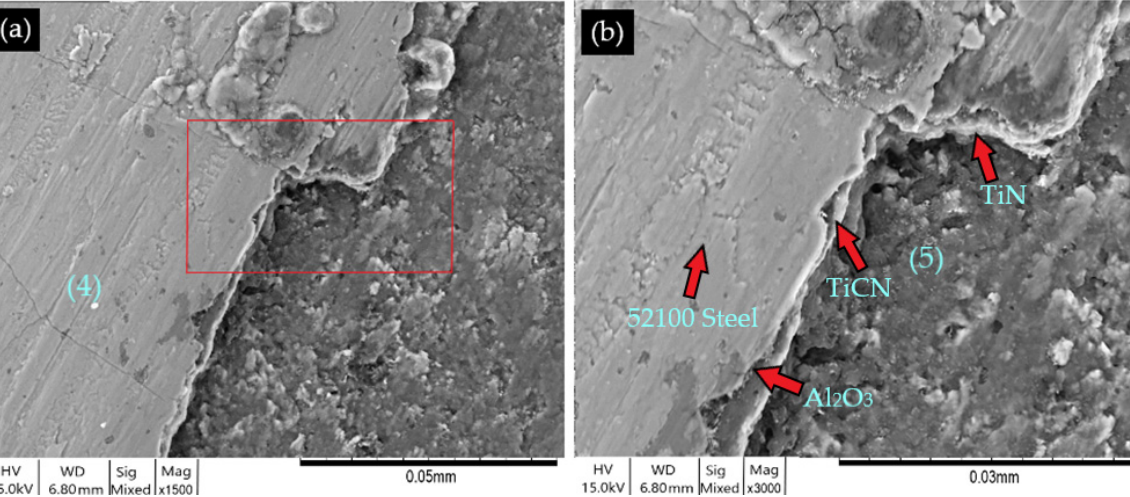
Figure 7. SEM images of Coating A after pin-on-disc Test 1a: ( a ) ×1500 magnification, ( b ) ×3000 magnification.